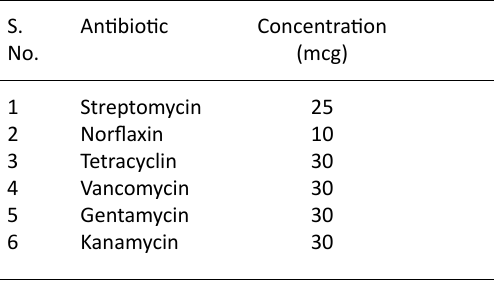
Table 1. Antibiotics used for antibiotic resistance